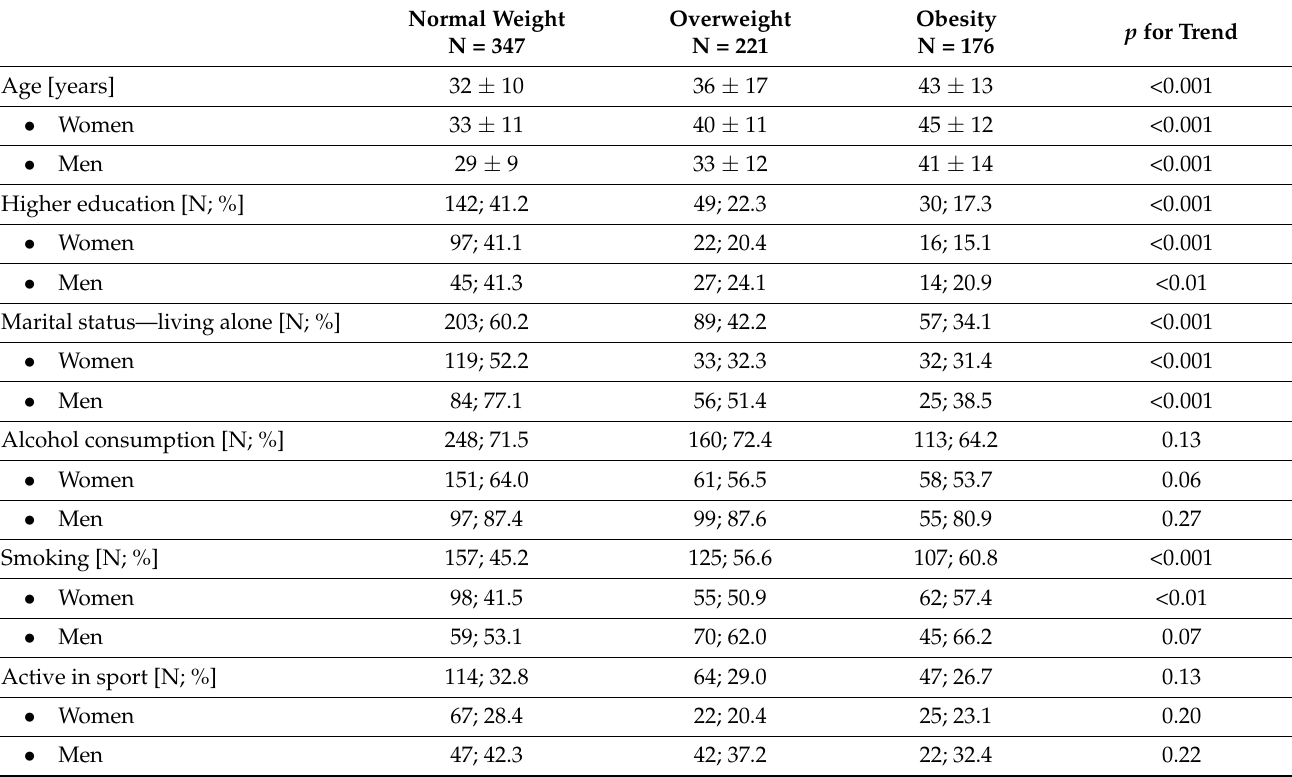
Table 1. Basic characteristics of the study group according to nutritional status. Normal Weight Overweight Obesity p for Trend N = 347 N = 221 N = 176 32 ± 10 36 ± 17 43 ±